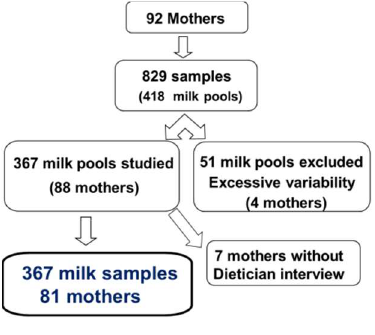
Figure 1. flow chart.